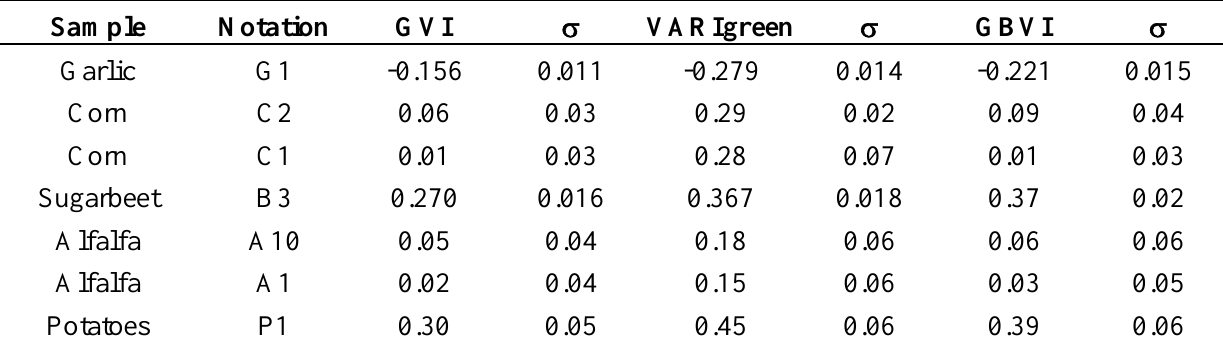
Table 3. Mean GVI, VARIgreen and GBVI values with their standard deviation (  ) extracted from the CHRIS image acquired at near nadir view and using bands 25 (0.674  m, red), 14 (0.563  m, green) and 8 (0.502  m, blue). Values were extracted for the whole plots associated to the different crops. GVI and GBVI were obtained from at-surface reflectivities, whereas VARIgreen was obtained from TOA